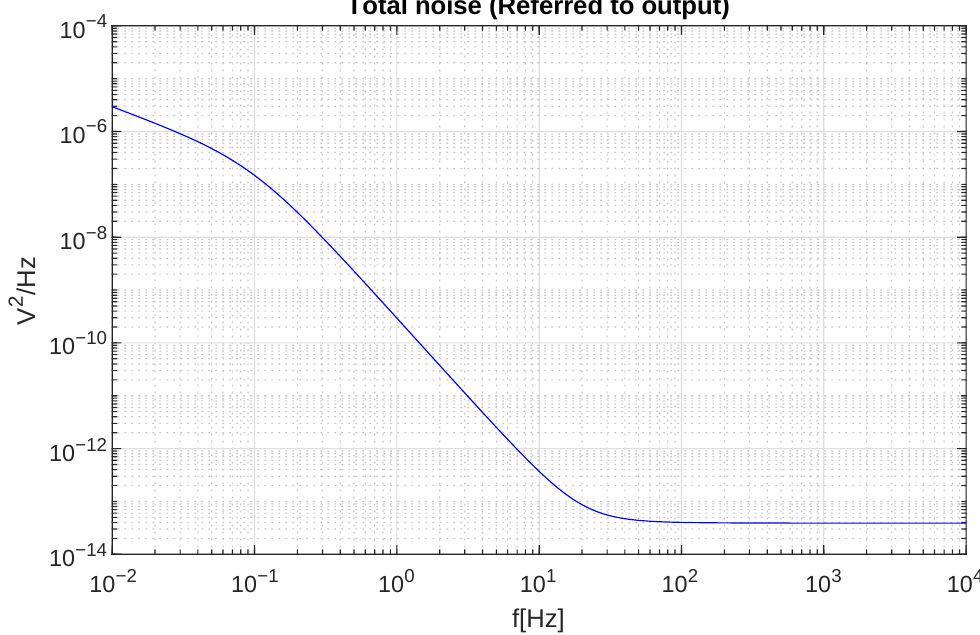
Figure 5. Minimum noise obtained for the analog front-end of the Transmitter device, measured at the output of the amplifier, with gain set to 50V/V. The flat noise level corresponds to the expected input-referred noise for the AD8429, which is stated at around 3nV/